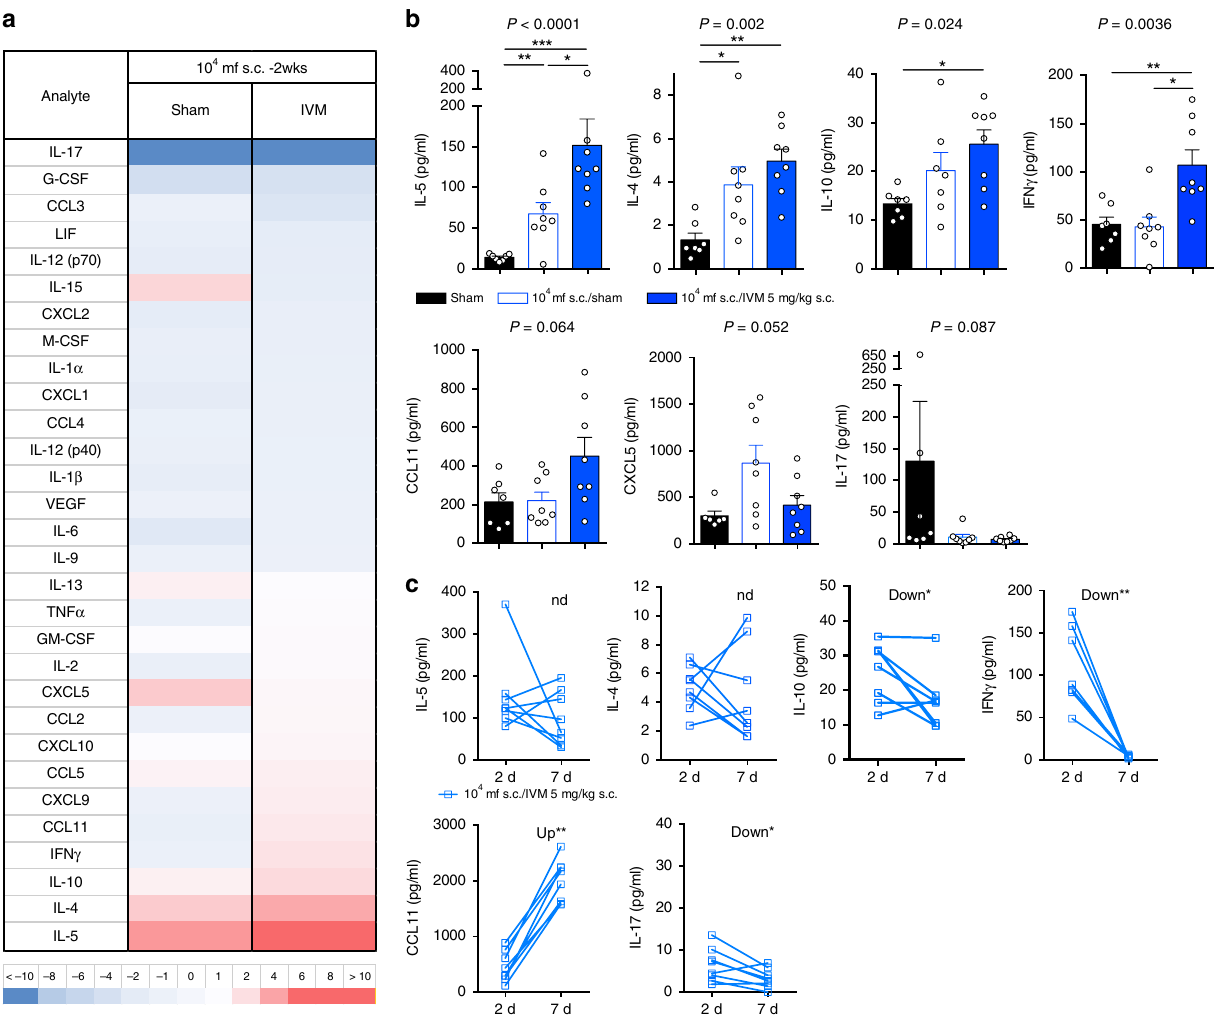
Fig. 4 Type-2 systemic in fl ammation is evident post-ivermectin treatment of L. loa micro fi laraemic mice. a Plasma cytokines/chemokine changes 2 days post infusion with 40,000 puri fi ed L. loa mf into BALB/c mice with prior immune-priming via s.c. inoculations of 1 × 10 4 heat-killed L. loa mf and either IVM 5 mg/kg ( n = 8) or sham-treatment s.c. at the point of infusion ( n = 8). Plotted is median fold change compared with non-immune primed, sham-treated L. loa micro fi laraemic controls ( n = 7). Colour scale depicts< − 10 (dark blue) to >10 (dark red) fold difference with white being 1 (i.e., no difference). b Cytokines/chemokines with ≥ twofold increase or decrease following immune-priming ( n = 8) and/or immune-priming + IVM treatments ( n = 8) compared with non-immune primed, sham-treated L. loa micro fi laraemic controls ( n = 7). Data plotted are individual data and means± SEM. Signi fi cant differences are determined by one-way ANOVA with Dunnett ’ s post-hoc tests of either raw or log-transformed data (IL-4, 5, 10, CCL11, CXCL5) or Kruskal – Wallis tests with Dunn ’ s post-hoc tests (IFNg, IL-17). c Changes in circulating cytokine/chemokine levels between 2 and 7 days post-IVM treatment in immune-primed L. loa micro fi laraemic mice ( n = 8). Plotted are individual data. Signi fi cant differences are determined by paired Student's T tests (IL-4, -5, -10) or Wilcoxon tests (IFNg, CCL11, CXCL5, IL-17). All data are pooled from two individual experiments. Signi fi cance is